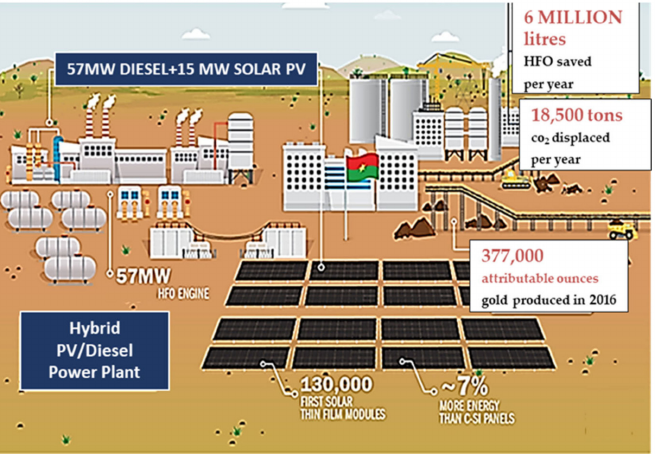
Figure 2. IAMGOLD Essakane (Burkina Faso) project (2018) flyer, PV/Diesel Hybrid Power Plant, with its key